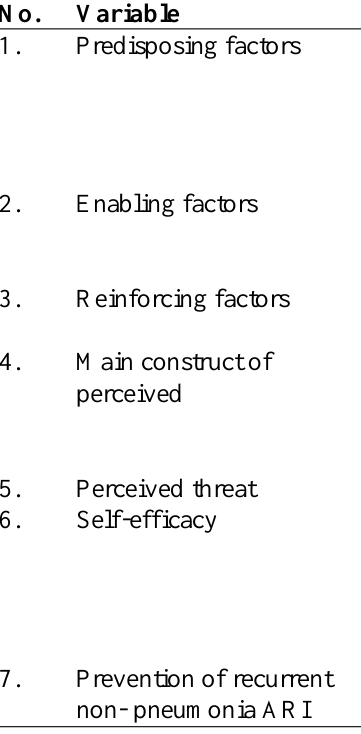
Tabel 2 Reliability test results development of model on mothers self-efficacy in